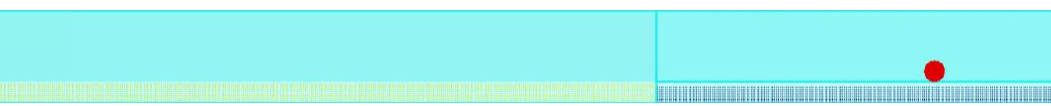
Figure 3. Pipeline equilibrium scour terrain and depth in clear water.